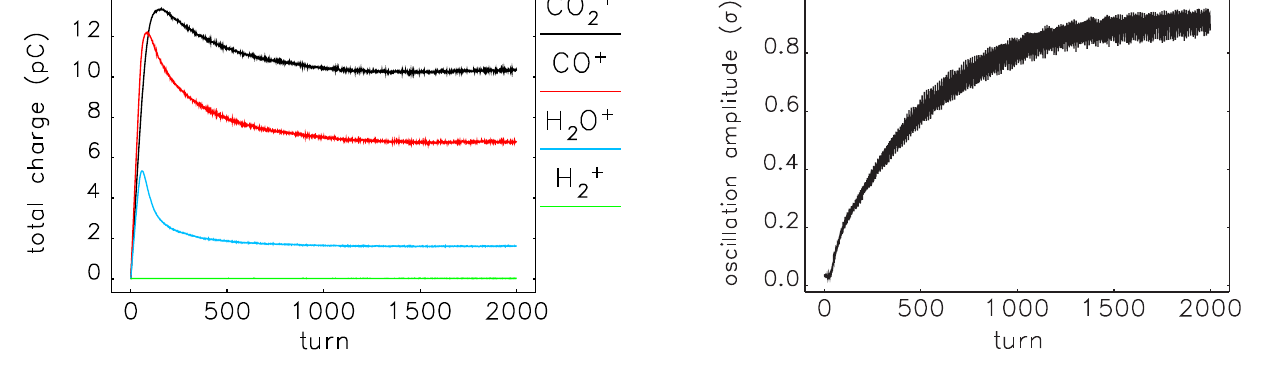
FIG. 2. Total charge of each ion species in the baseline APS simulation.